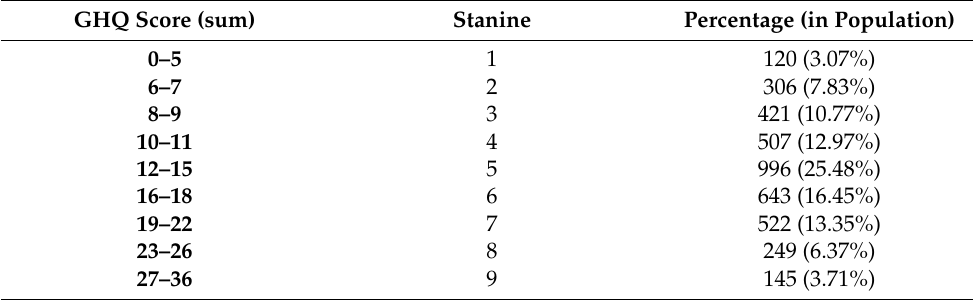
Table 9. The stanine normalization of the GHQ-12 ( N = 3909 German teachers). GHQ Score (sum) Stanine Percentage (in